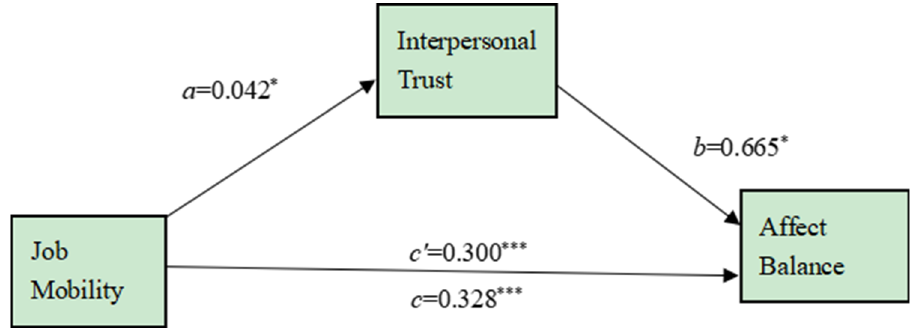
Figure 2. Beta coefficients for the mediating effect of interpersonal trust in the relationship between job mobility and affect balance. Note. * p < 0.05, *** p <